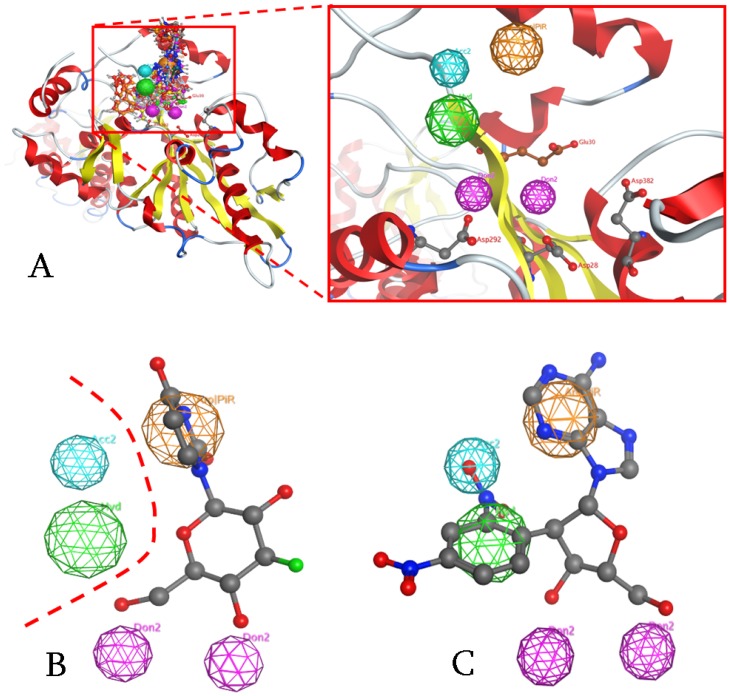
The Pharmacophore proposed for the catalytic site of PARN.(A) All known inhibitors were used to elucidate the consensus PARN Pharmacophore. The three Aspartic acid amino acids of the catalytic triad (Asp28, 292,382) and the Glutamic acid (Glu30) are shown in ball and stick representation. Purple and blue color correspond to electron donating and accepting groups, orange to aromatic moieties and green to hydrophobic interactions. (B) Our proposed pharmacophore is in accordance with our most active compound (U1) for PARN. In contrast, U2 and FU2 compounds are completely inactive, since they are missing the A electron donating position. (C) The DNP-poly(A) compound was identified as a strong in silico candidate compound that satisfied all pharmacophore 3D annotation points.